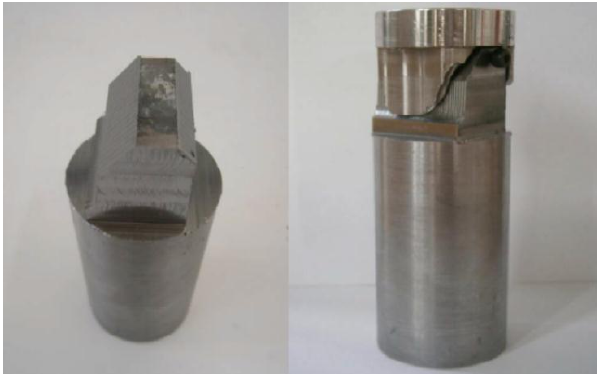
Figure 7. The platform for mounting the workpiece on the machining center bed for the second machining stage.